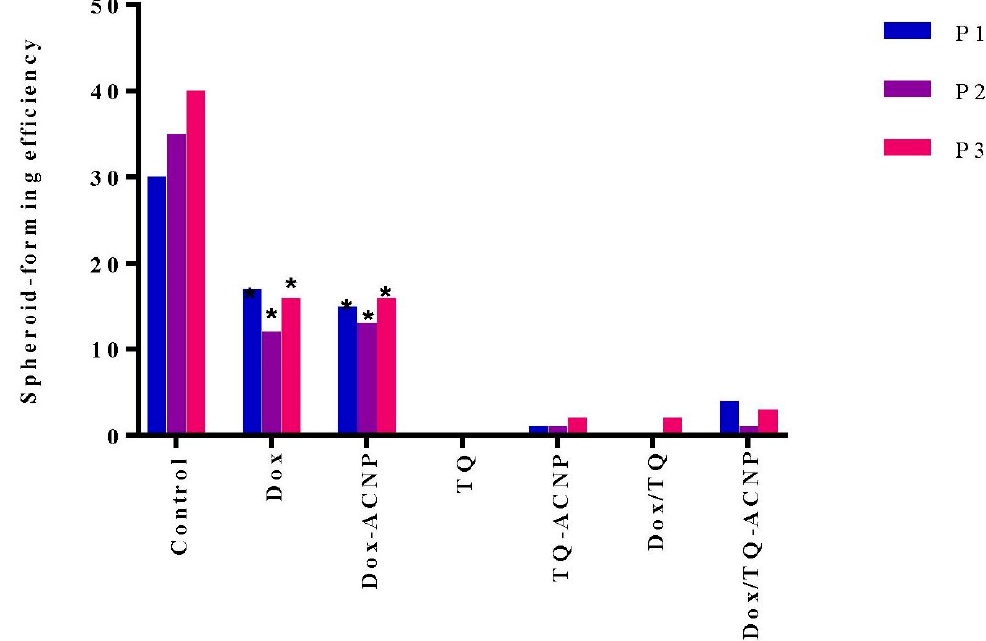
Figure 11. Self-renewal efficiency of MDA MB 231 CSCs after treatment at first passage through to the third passage. P1 = first passage; P2 = second passage; P3 = third passage. * p < 0.05 compared to